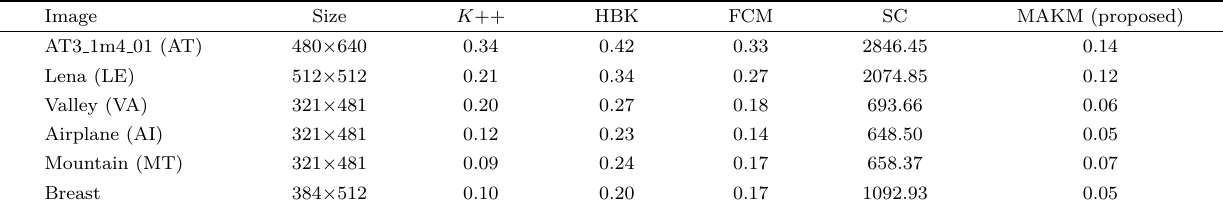
Table 7 Comparison of proposed algorithm with K ++, HBK, FCM, and SC in terms of mean computation cost (s) for AT, LE, VA, AI, MT, and Breast images Image